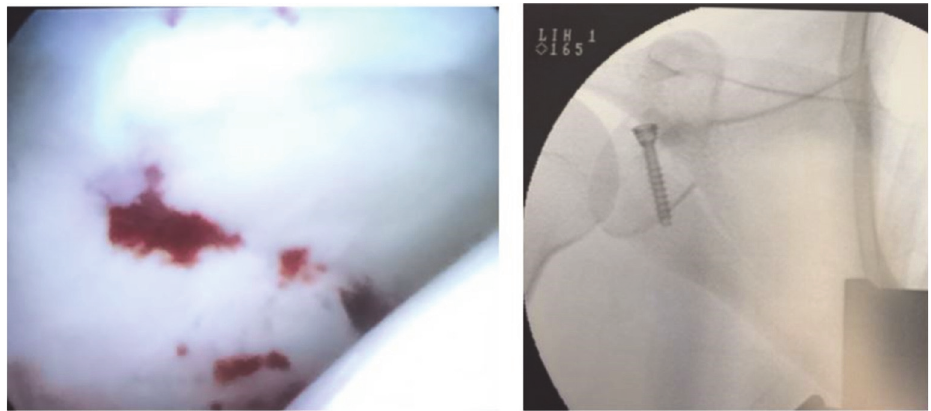
Figure 3: Arthroscopic and fluoroscopic